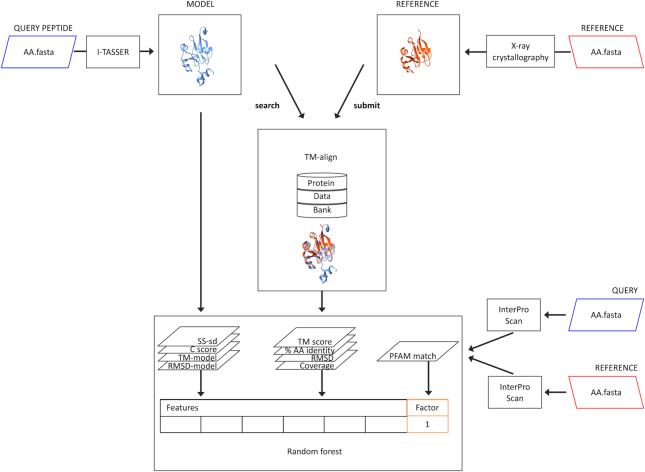
Pfam code agreement as a proxy for predicted protein structure quality. A query peptide sequence is submitted to I-TASSER software to predict its 3D structure (colored blue). Metrics describing the predicted structure (“model”) are extracted for downstream analysis. The model is compared with empirically determined protein crystal structures available in the PDB using TM-align, from which the closest structural homologue is identified ("reference"; colored red). Metrics describing the alignment are also extracted. Pfam codes are assigned to primary peptide sequences that constitute the model and reference structures using InterPro Scan software (lower right side). The presence of at least one matching Pfam code assigned to the query and reference peptides (“PFAM match”) indicates greater likelihood of structural similarity between the model and the reference. Models with this feature are assigned as “high-confidence.” The ability of each extracted metric (“Feature”) to predict the high-confidence category (“Factor”) is assessed, and then a RF classifier is trained to identify the factor using all available features.